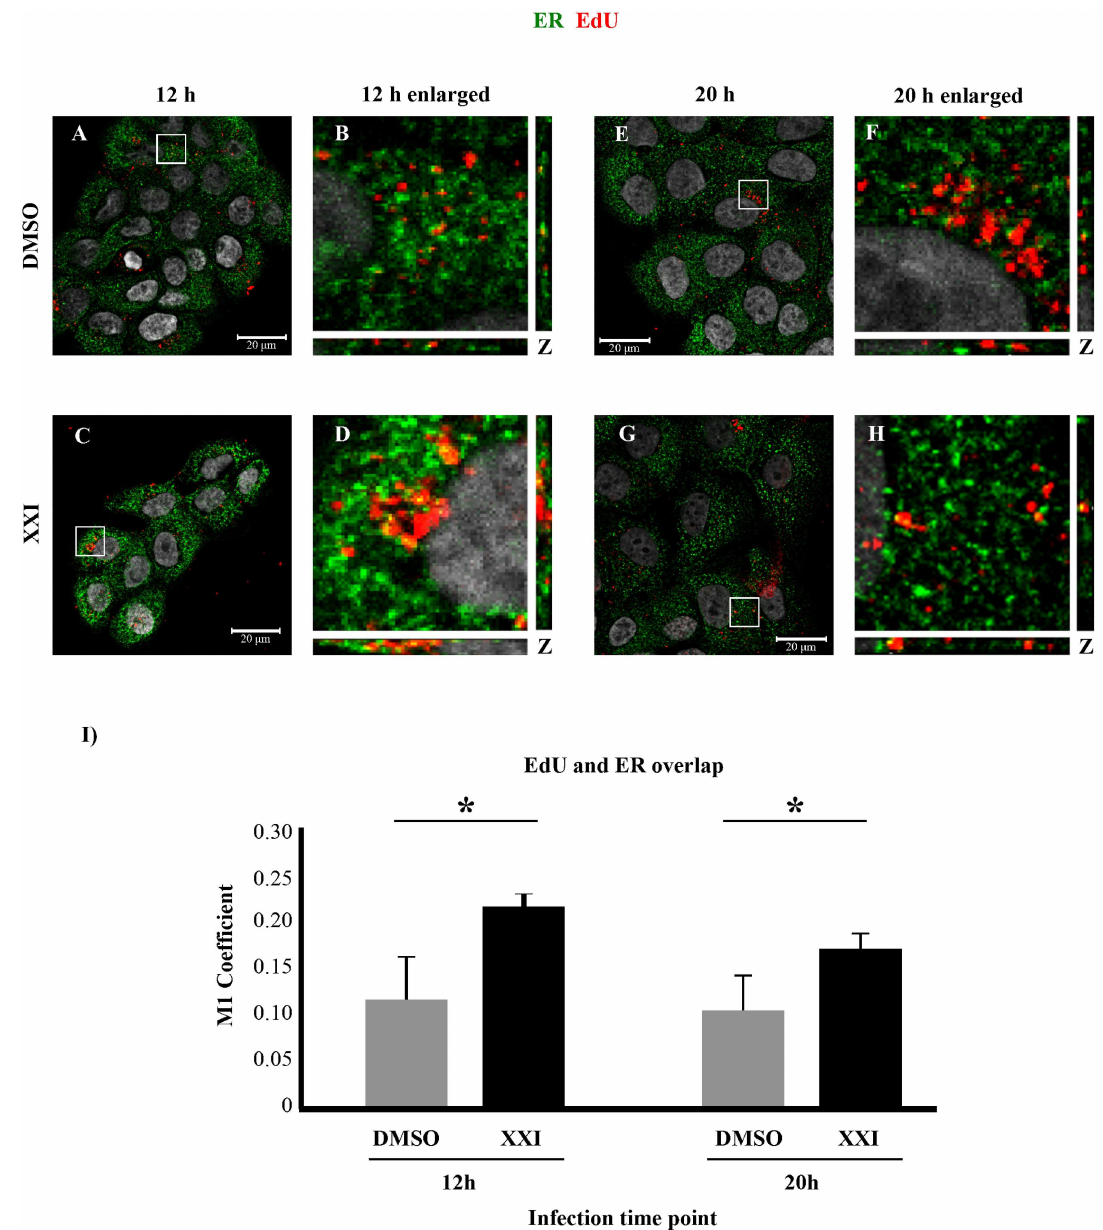
Fig 5. γ -secretaseinhibition causesincreasedER trafficking of EdU-labeled pseudogenome. DMSO or XXI treated cells wereinfectedwithHPV16PsV harboring EdU-labeledpseudogenome for 12 h (A-D) or 20 h (E-H). ER was stainedwithBiP (green),EdU-labeledpseudogenome wasvisualizedby Click-itreaction(red) andthe nucleiwerestainedwithDAPI (grey).(A-D andI) DMSO treatedHaCaTsshowedsignificantlylesscolocalization compared to XXI treatedHaCaTsat 12hpi(one-tailed t-test p = 0.008).(E-H andI) At 20hpi,significantly higherlevelsof colocalization weredetectedin XXI treatedcells compared to DMSO treatedcells(one-tailedt-test p = 0.02). (I) M1 coefficient,percentageof redsignal(EdU-labeled pseudogenome) overlapping withgreensignal(BiP) was calculated with the helpof JaCOPplugin with nineconfocalscansfor eachcondition. (A-H). Error bars showthe standard deviationin measurements from threeindependent replicates.